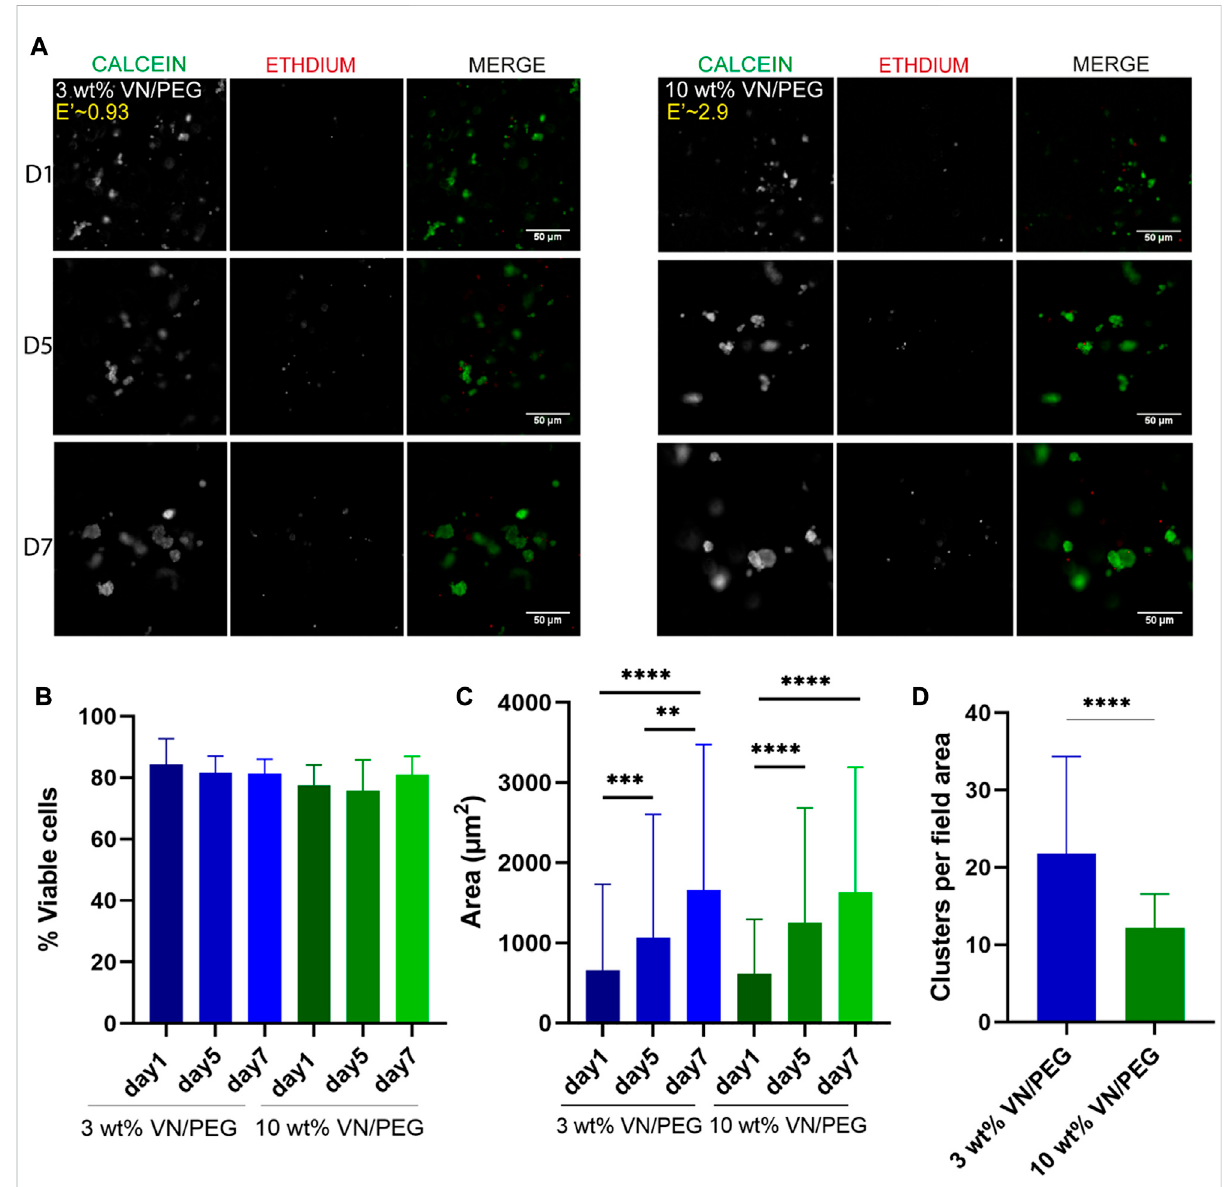
FIGURE 4 Cell viability in 3DVN based hydrogels. (A) . Imagesof calcein-AM (green) and ethidium homodimer-1 (red) for SK-N-BE(2) in3 and 10 wt%VN/ PEGwith500 μ g ml − 1 ofVN. (B) .Quanti fi cationofSK-N-BE(2)viabilitywithANOVAstatisticalmethod. (C) .Cellclusterareafor3and10 wt%VN/PEG hydrogels after 1, 5, and 7 days (scale bar 50 µm). Statistical differences were analyzed by Kruskal – Wallis test. (D) . Mean number of clusters per fi eld area for 3 and 10 wt% VN/PEG hydrogels, grouping images from 1, 5 and 7 days together. Mann-Whitney analysis was performed to compare the number of clusters. A total of 15 images (3 replicates, 5 images each) were taken per sample